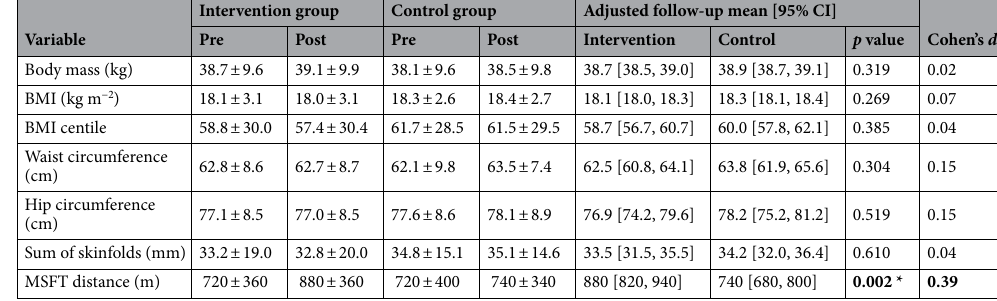
Table 2. Body composition and physical fitness for the intervention and control group at baseline and follow-up. Data are mean ± SD. Significant values are in bold. *Significant difference between intervention and control group at follow up ( p <